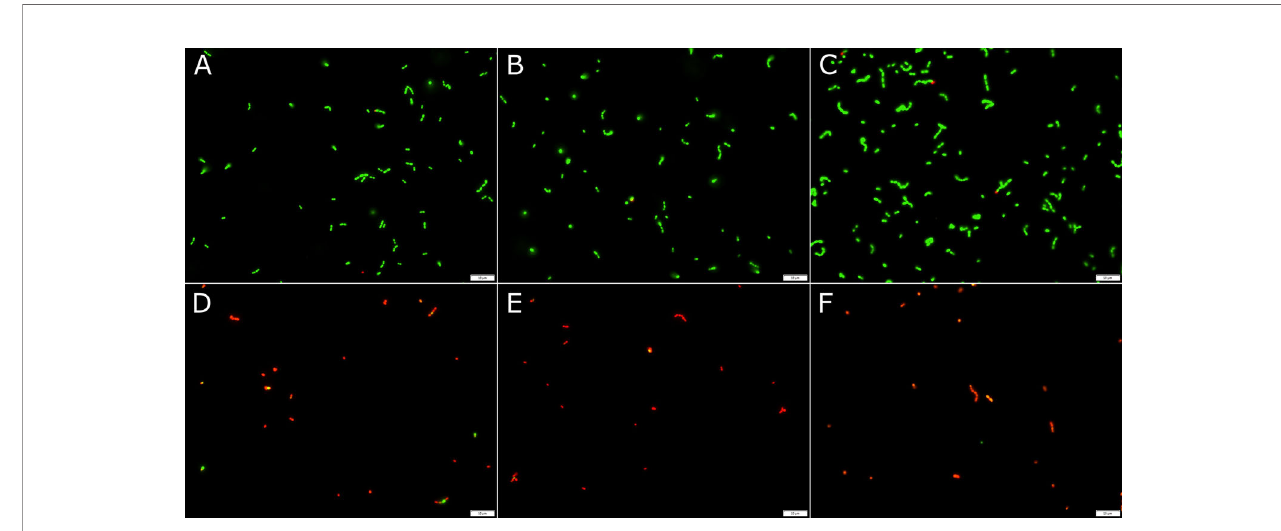
FIGURE 1 | Fluorescent microscopy images of E. faecalis treated with either sterile distilled water (A – C) for 30 min, 1 h or 2 h, respectively, or 0.313% IP6 (D – F) for 30 min, 1 h or 2 h, respectively. Bacteria were stained with the Live/Dead ® BacLight ™ bacterial viability kit. Red staining indicates membrane damage.